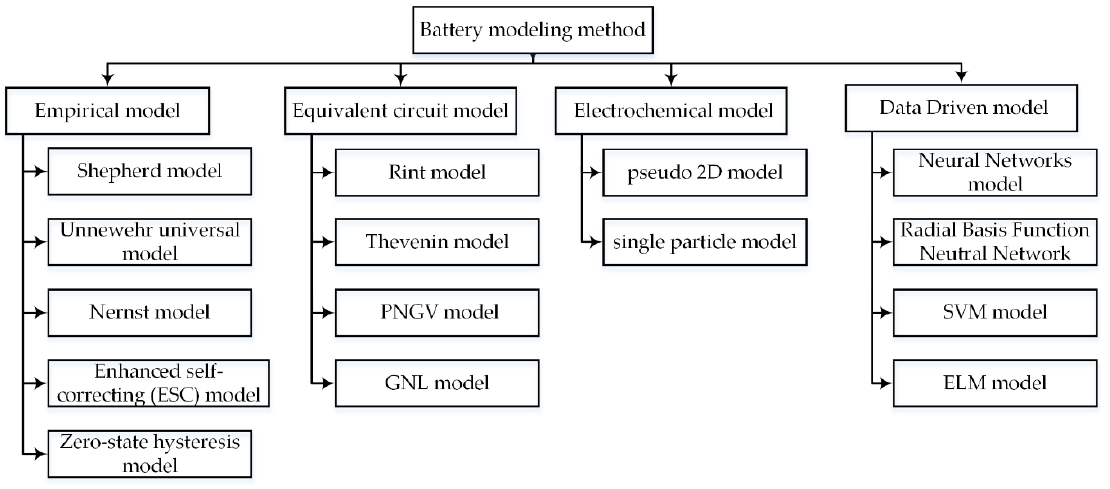
Figure 4. The classifications of battery modeling methods. Table 4. Pros and cons of the modeling methods.